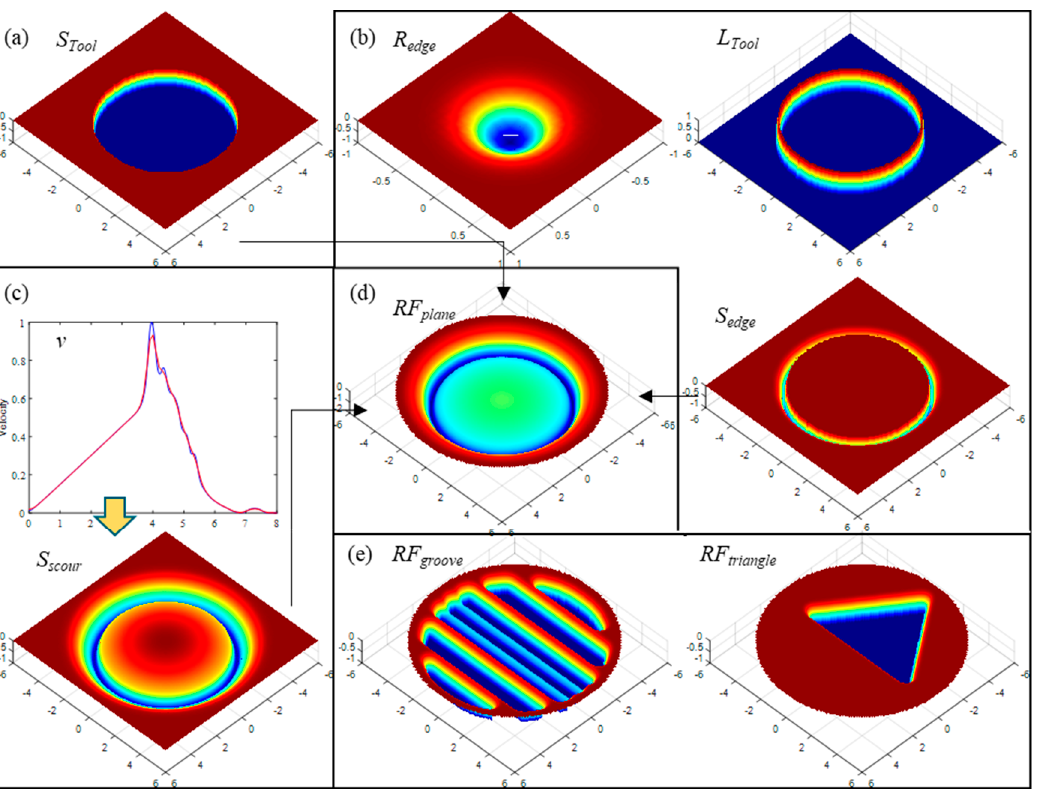
Figure 15. Removal distributions model: ( a ) the shape of the tool’s working surface, ( b ) the edge removal distribution model, ( c ) the fluid scouring removal model, ( d ) the plane tool’s removal function, and ( e ) the tool’s removal function with complex working surfaces.